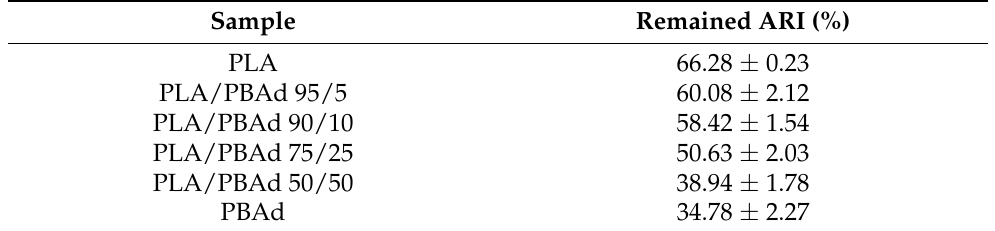
Table 4. % Aripiprazole drug remained in the MPs at the end of the in vitro release study.